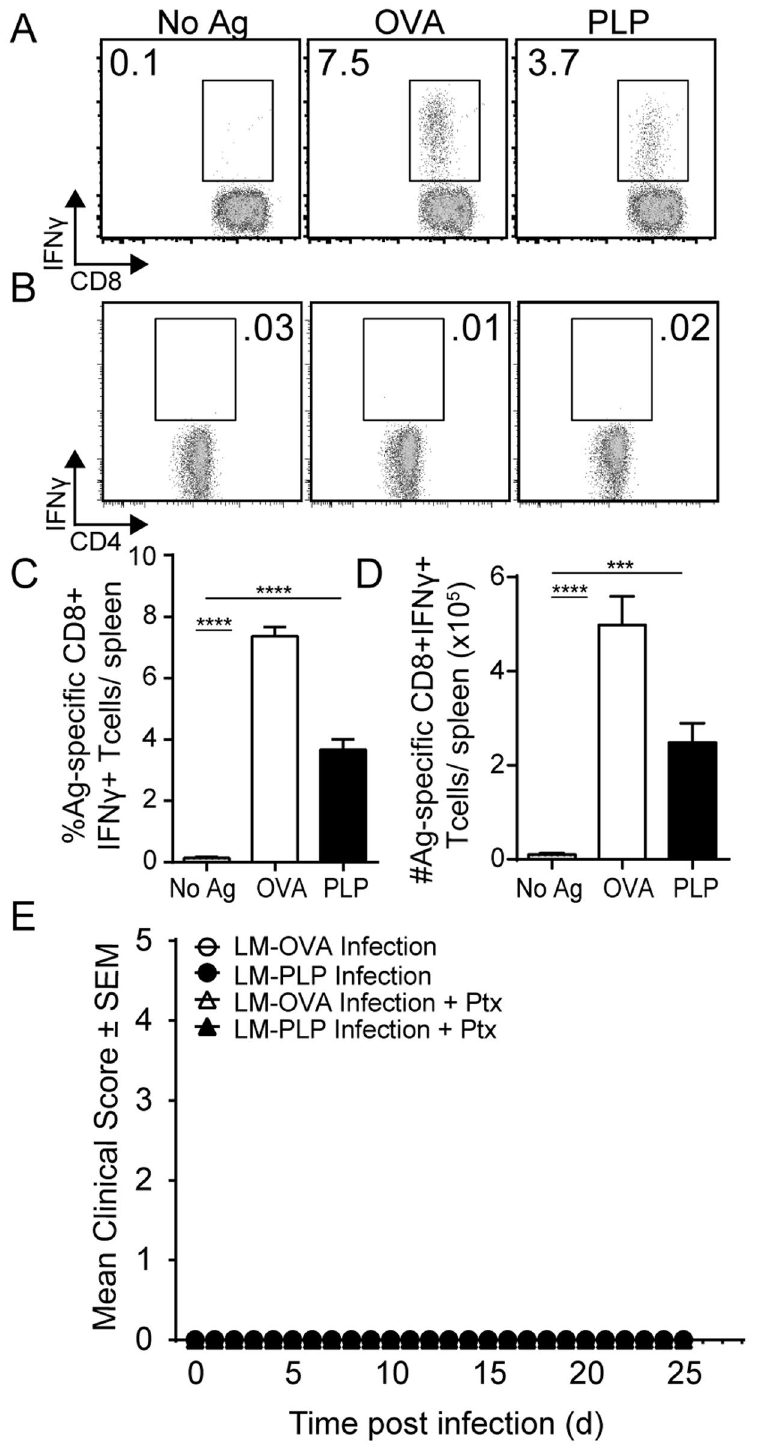
Figure 1. Infection with LM-PLP generates PLP-specific CD8 T cells that are not pathogenic. Intracellular cytokine staining was performed using bulk splenocytes harvested from LM-PLP infected B6 mice on d7 post infection. Splenocytes were left unstimulated, or stimulated with either OVA257-264 (positive control) or PLP178-191. Representative flow plots show CD8 ( A ) and CD4 ( B ) T cell responses from LM-PLP-infected mice. Summary bar graphs display the frequency ( C ) and absolute numbers ( D ) of antigen-specific CD8 T cell responses to indicated antigens. ( E ) Mice were infected with either LM-OVA or LM-PLP and followed for neurologic signs of disease with or without pertussis toxin administration. Data are representative of at least three independent experiments in each panel with at least six mice per group per experiment. *** p < 0.001, **** p <